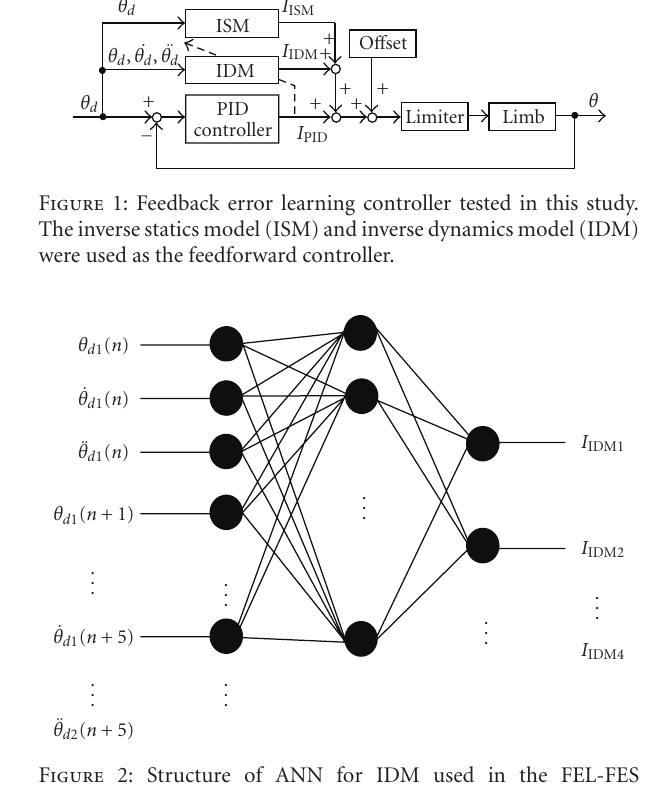
Figure 2: Structure of ANN for IDM used in the FEL-FES